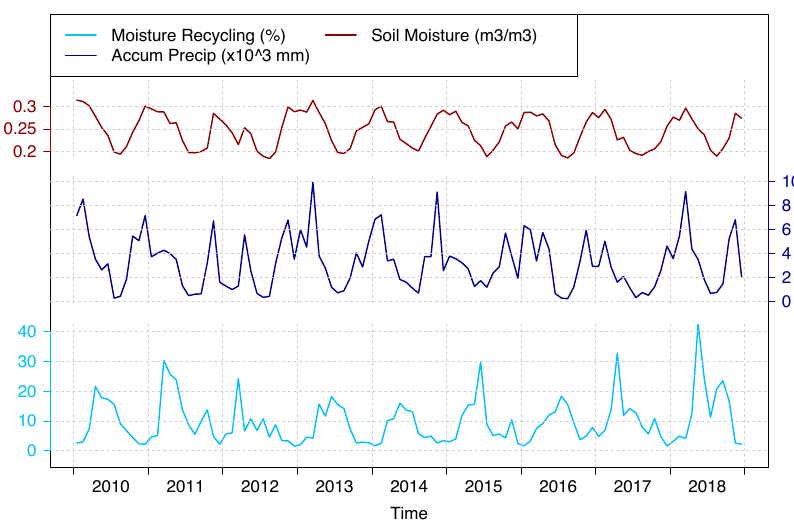
Figure 7. Monthly values of moisture recycling, mean soil moisture, and accumulated precipitation over the IP for the period 2010–2018 only for the simulation including data